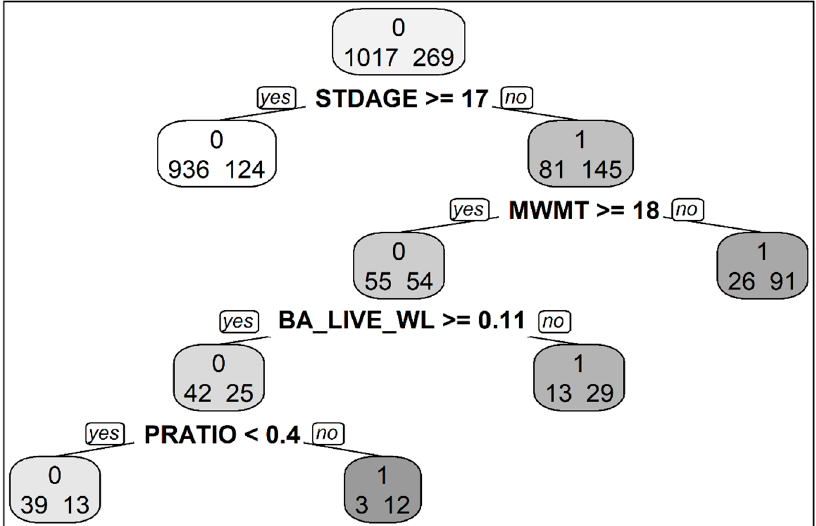
Figure 3. Classification tree predicting western larch seedling presence, with complexity parameter (CP) = 0.027. STDAGE = stand age in years, MWMT = mean warmest month temperature (°C), BA_LIVE_WL = live basal area of western larch (m 2 /ha), and PRATIO = ratio of growing-season precipitation to mean annual precipitation.